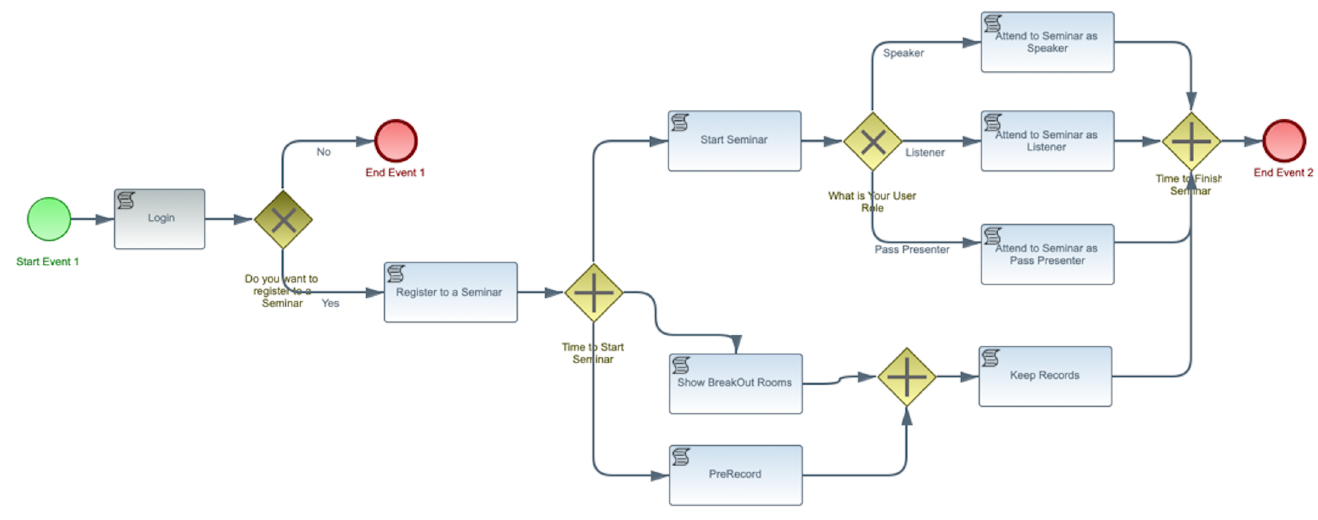
Figure 7. BPMN of webinar system